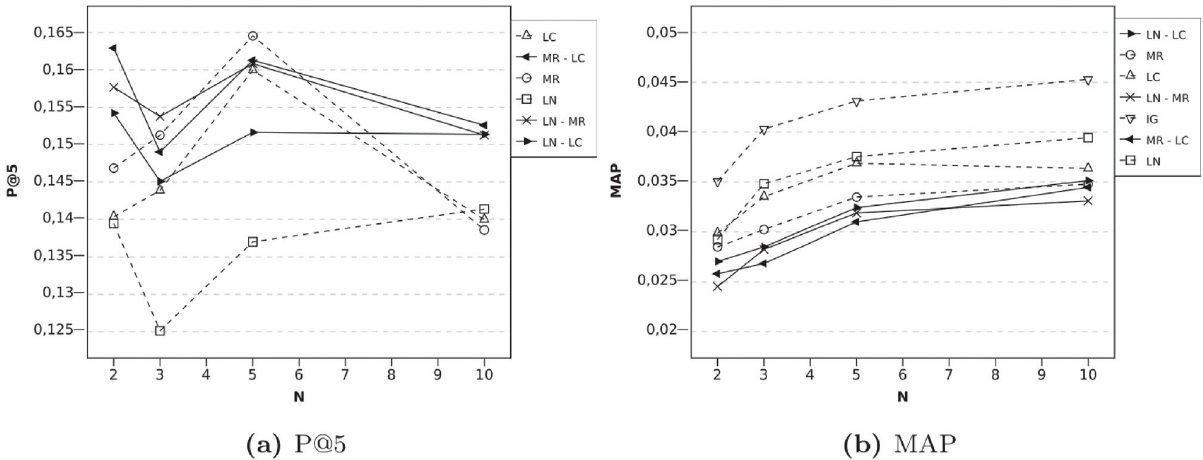
Fig 5. Evolution according to N, High Order Profile Expansion using serial combinations with UL techniques and l = 2. Fig (a) reports P@5 results and (b) shows MAP.